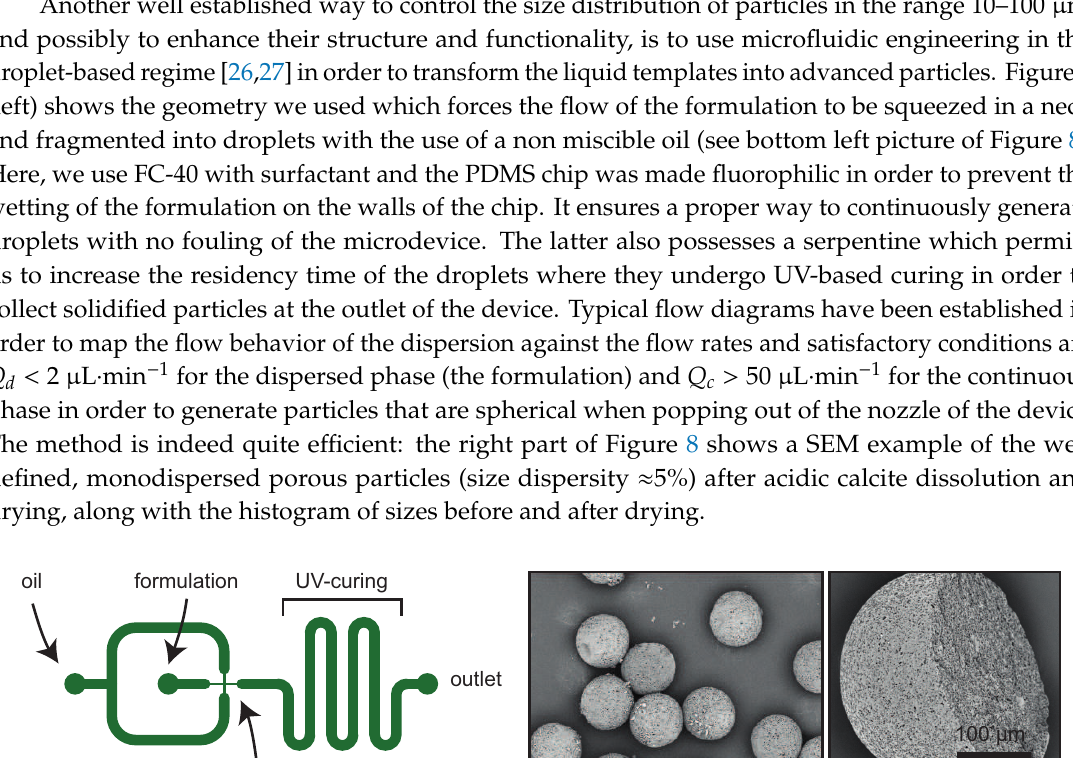
Figure 8. Left : schematic principle view of the microfluidic setup used to produced particles. Right : SEM views of the particles after calcite dissolution and drying, and histogram of size reduction after drying.